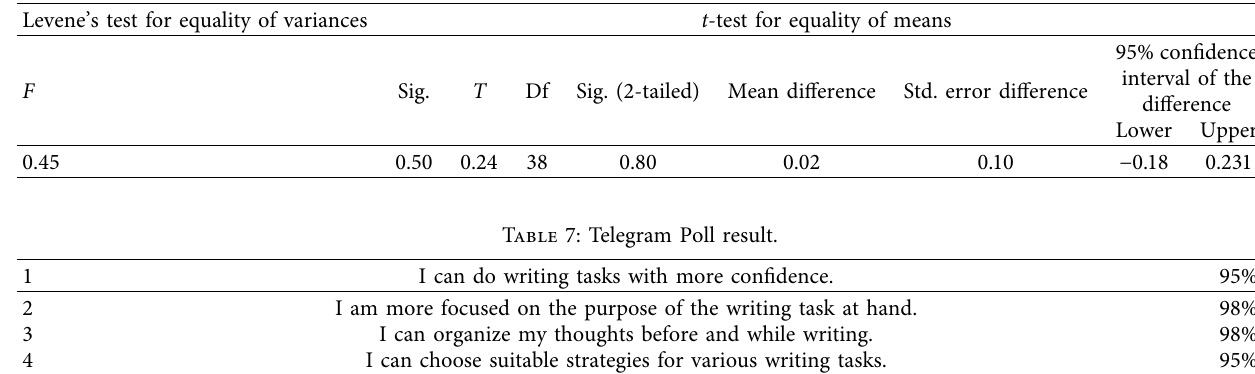
Table 6: Independent samples t -test results for the moderating effect of gender on the posttests.